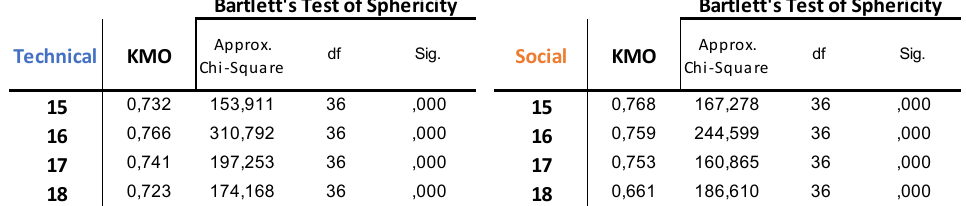
Figure 5. Kaiser-Meyer-Olkin (KMO) and Bartlett’s test values of sampling Figure 5. Kaiser ‐ Meyer ‐ Olkin ( KMO) and Bartlett’s test values of sampling adequacy.